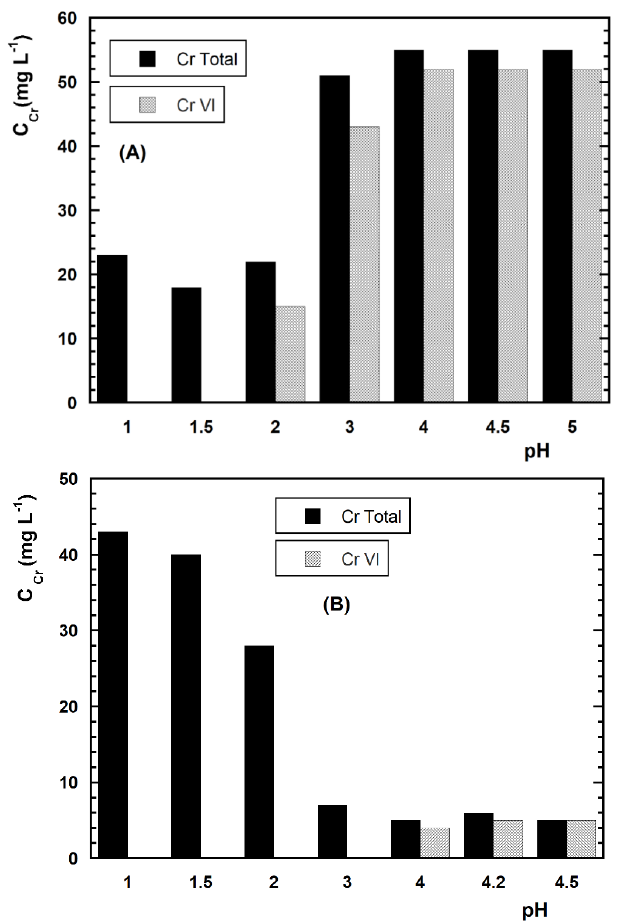
Figure 3. Residual chromium concentration in solution as a function of pH. Sorbent used: ( A ) oxyhumolite; ( B ) iron humate. Adapted from Janos et al. [6].